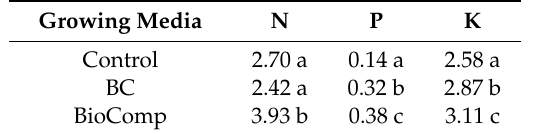
Table 4. Leaf N, P, and K contents (%) in Syngonium podophyllum produced in three growing